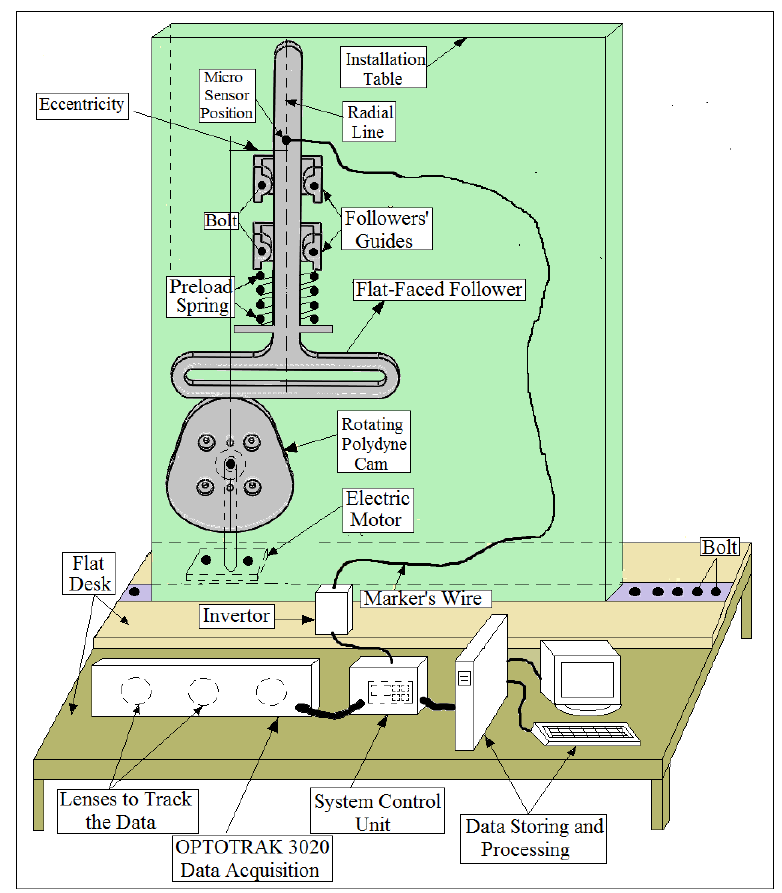
Figure 11. Experiment setup.